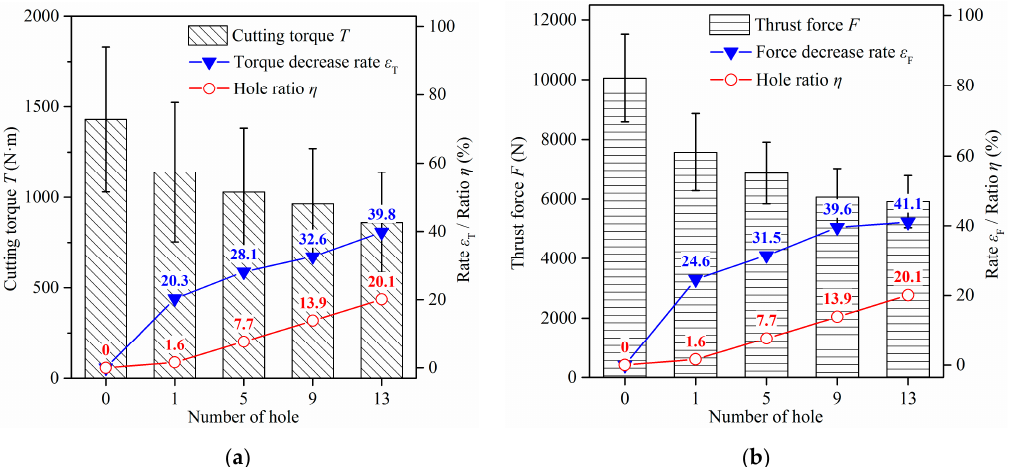
Figure 20. Effect of the hole number on ( a ) cutting torque and ( b ) thrust force under the confining pressure of 10 MPa.